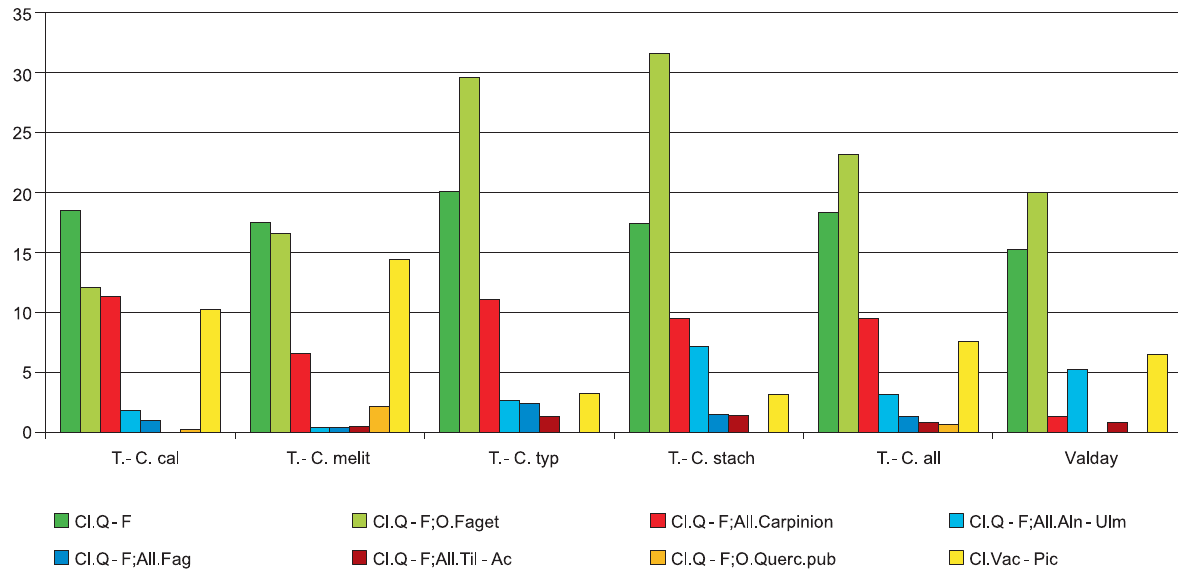
Fig. 2. Total frequency of vascular species characteristic of two phytosociological classes in the studied forest complexes Cl.Q-F – species characteristic of Querco-Fagetea